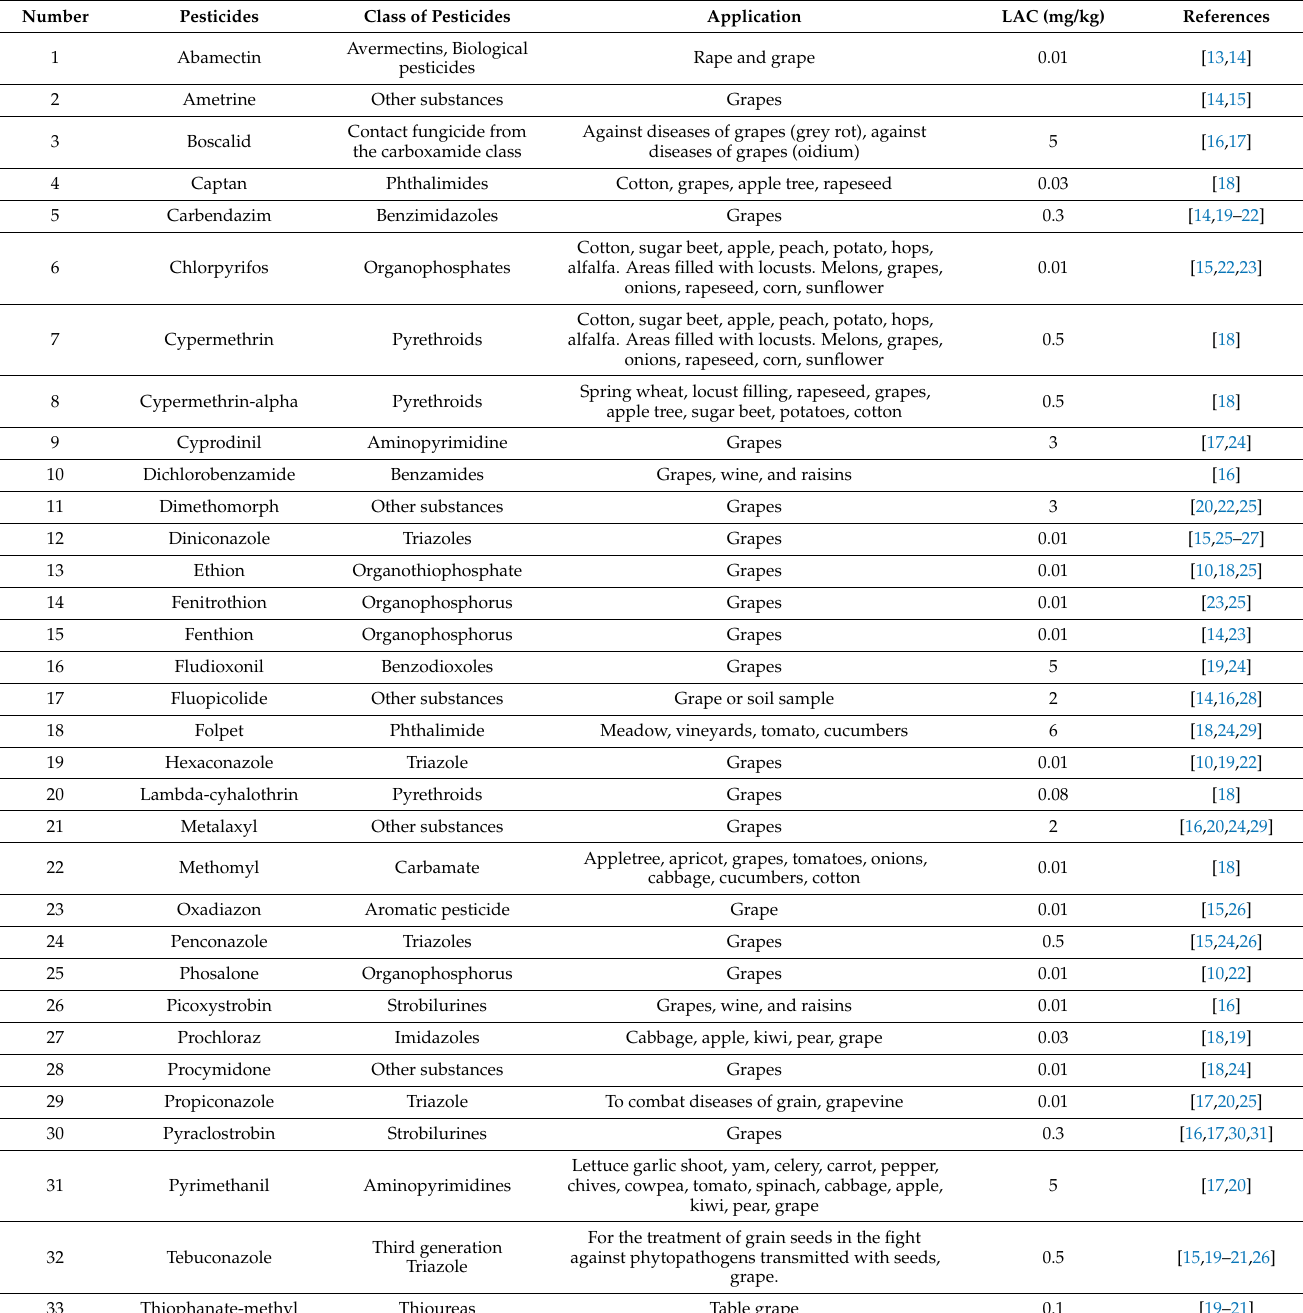
Table 1. List of pesticides most commonly used to control pests and diseases at different stages of grape cultivation.